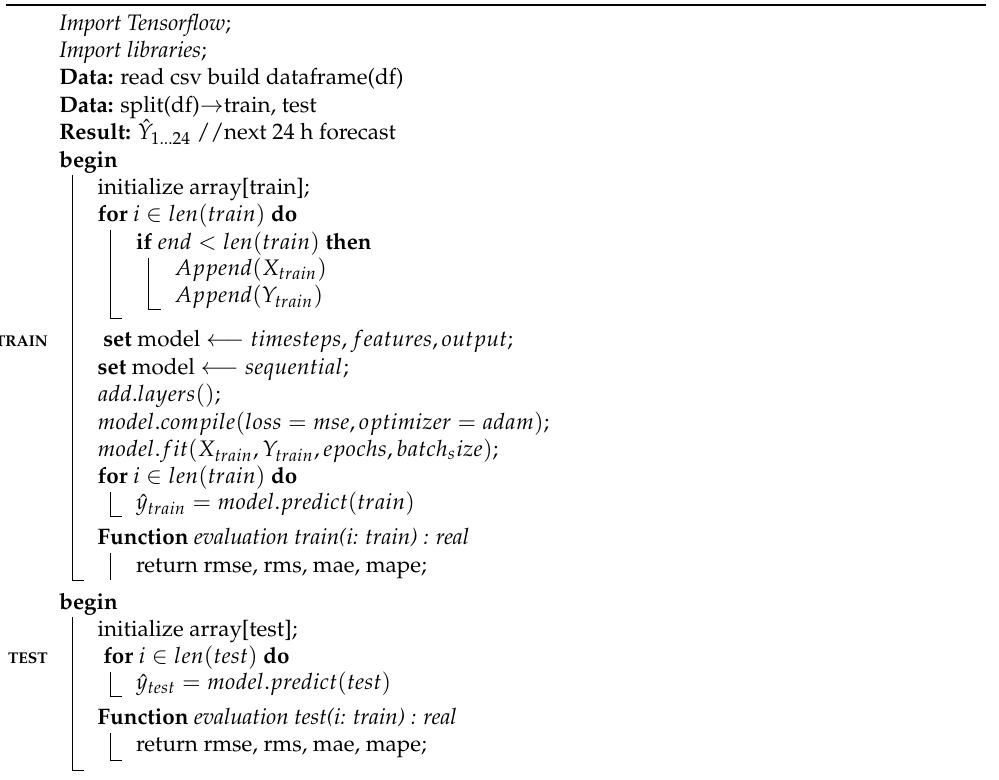
Algorithm 1: Machine learning forecasting algorithm (h = forecast